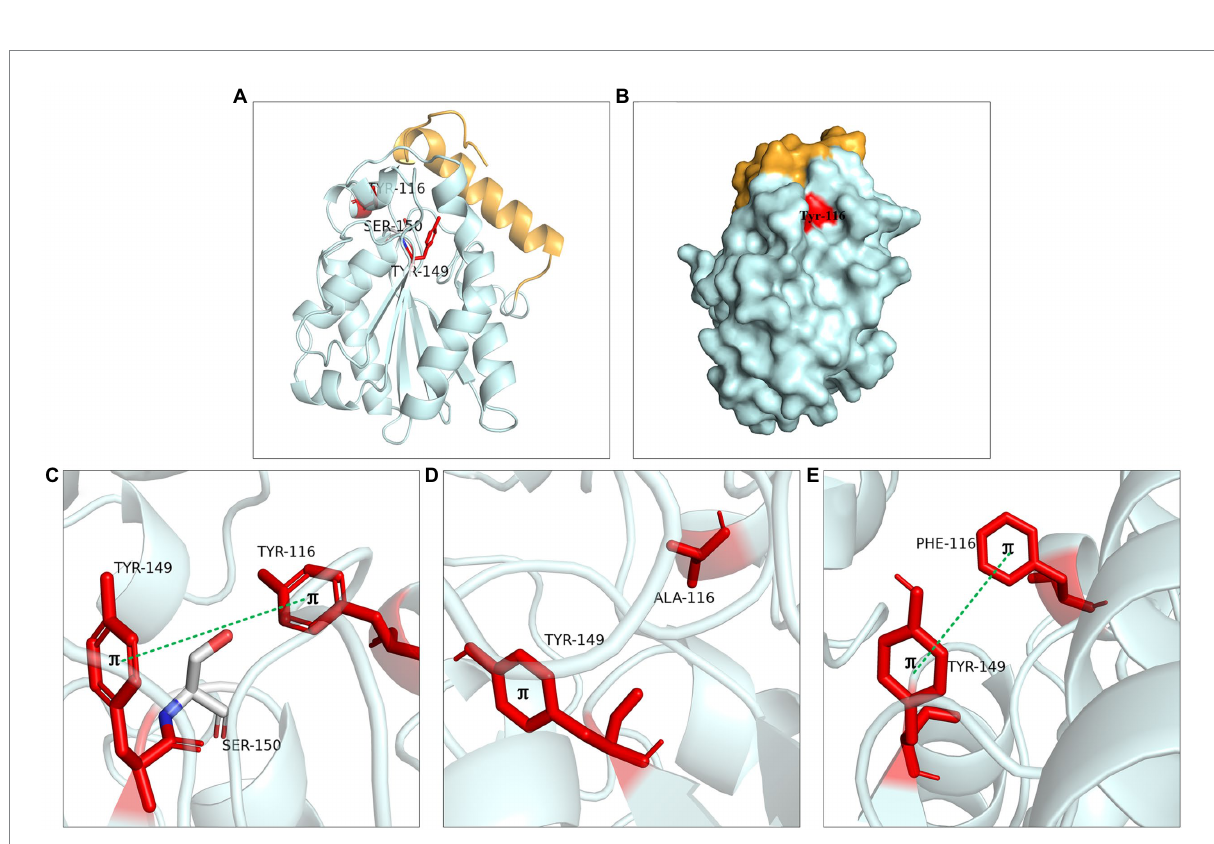
FIGURE 8 Catalytic function analysis of Tyr116 and Tyr149. (A) Spatial position of Tyr116 and Tyr149. (B) Surface model of Tyr116. (C) π bond interaction between Tyr116 and Tyr149. (D) No π bond interaction between Ala116 and Tyr149 of Y116A, (E) π bond interaction between the Phe116 and Tyr149 of Y116F.